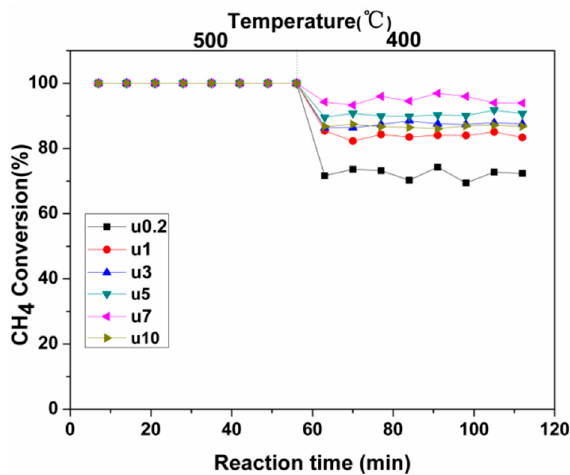
Figure 9. Catalytic performance of used catalysts with di ff erent H 2 S concentration. Gas composition: CH 4 (v% = 2%), O 2 (v% = 8%), H 2 S (v% = 0.02%), and N 2 (v% = 8 9.8%); Flow rate: 200 mL / min;